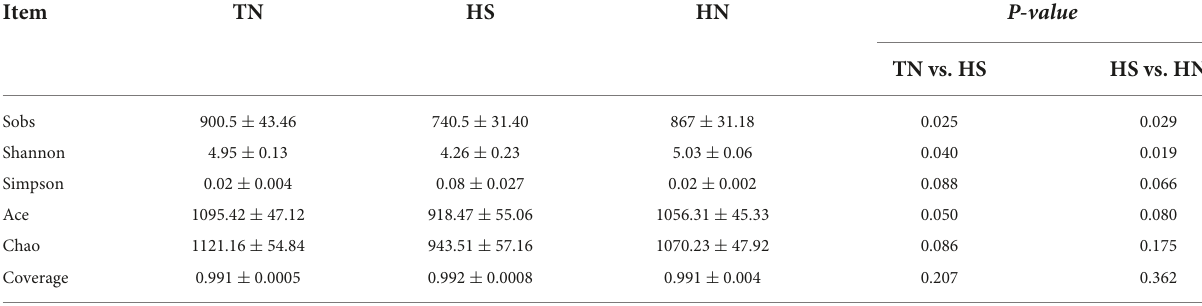
TABLE 7 Effects of dietary niacin on the diversity of ruminal bacteria of beef cattle under heat